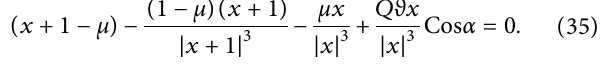
Figure 3: The position of collinear liberation points.